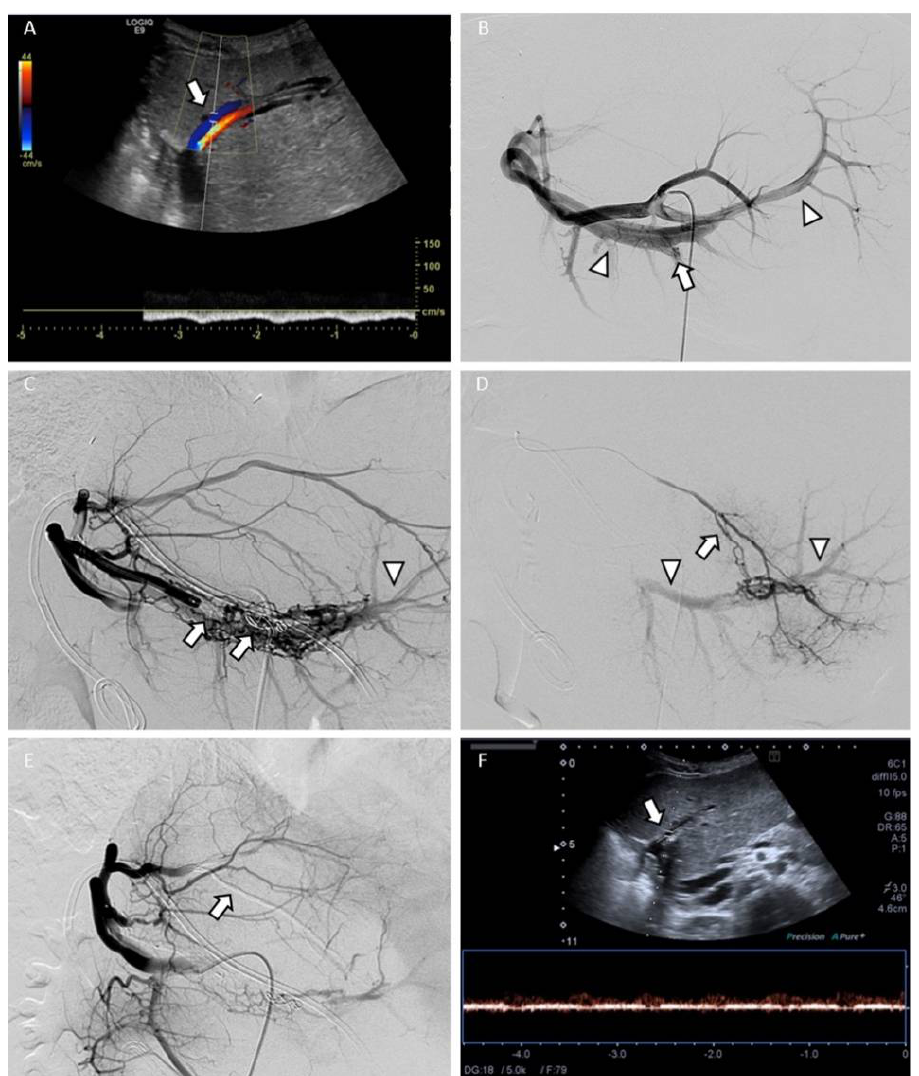
Figure 1. Endovascular approach: iatrogenic post-biopsy type 1 arterioportal fistula (APF) treated with transcatheter embolization in a 11-year-old child with left lateral segment orthotopic liver transplantation. ( A ) Color Doppler ultrasound (CDUS) diagnosis of hemodynamically significant APF with flow reversal in the segmental portal branch (arrow). ( B ) The celiac trunk angiogram shows the intrahepatic shunt (arrow) with abnormal opacification of the upstream and downstream segmental portal branch (arrowheads). ( C ) Complex APF revascularization through collateral vessels after embolization with microvascular plug and coil (arrows); arrowhead indicates persistent abnormal portal vein opacification. ( D ) Superselective catheterization of a collateral arterial branch (arrow); arrowheads indicate abnormal portal vein opacification. ( E ) Reduced portal vein opacification after transcatheter embolization of the collateral arterial branch with Onyx. ( F ) CDUS follow-up shows normal direction of blood flow in the segmental portal branch